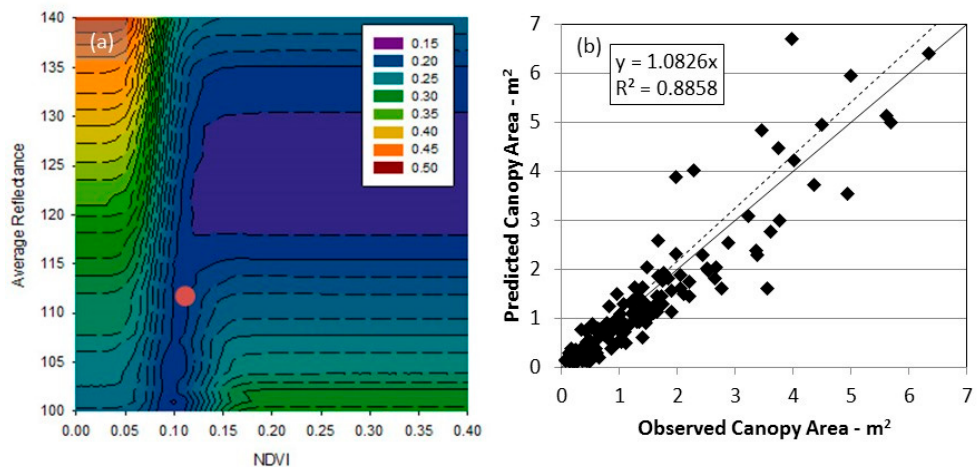
Figure 3. ( a ) Objective function showing RMSE as function of NDVI and AVGr; ( b ) scatterplot showing comparison between observed and predicted canopy areas for NDVI ≥ 0.12 and AVGr ≤ 111, as also seen in red dot shown on ( a ). In ( b ), the solid line represents the 1:1 line and the dashed line represents the regression line (significant at p < 0.001).